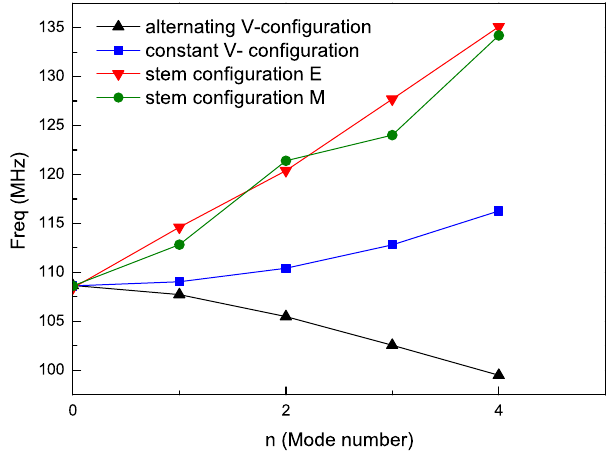
FIG. 20. Simulated dispersion curves of an Alvarez-type cavity with different stem configurations. Blue: constant V-configuration without stabilization. Red: stem configuration E of Fig. 16. Green: stem configuration M of Fig. 18. Black: alternating V-configuration.